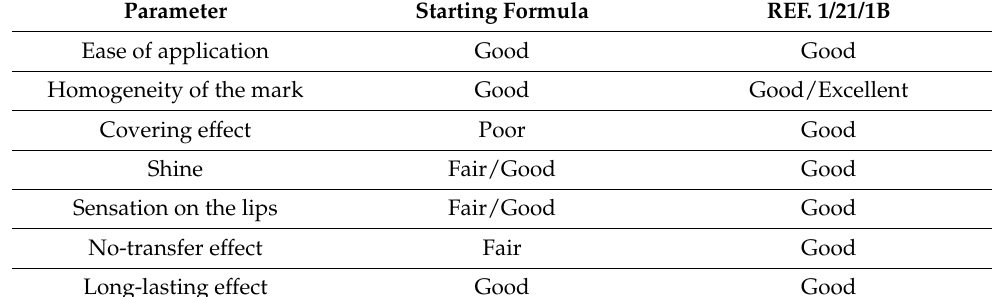
Table 13. Evaluation of the initial formula vs. Ref. 1/21/1B.